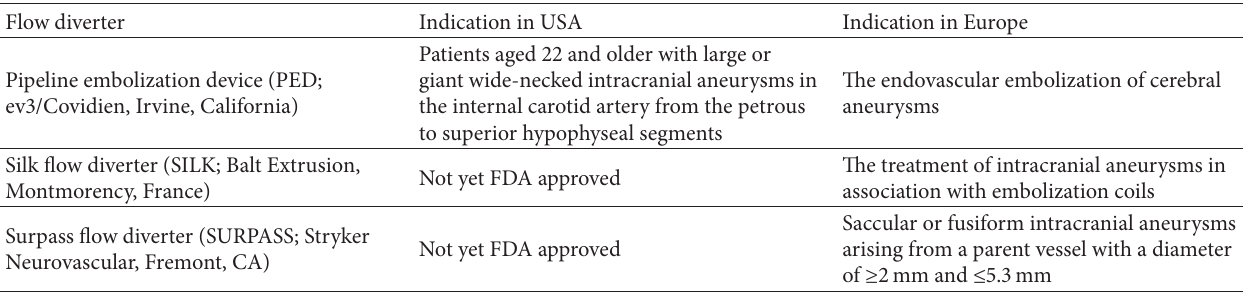
Table 2: On-label indications for flow